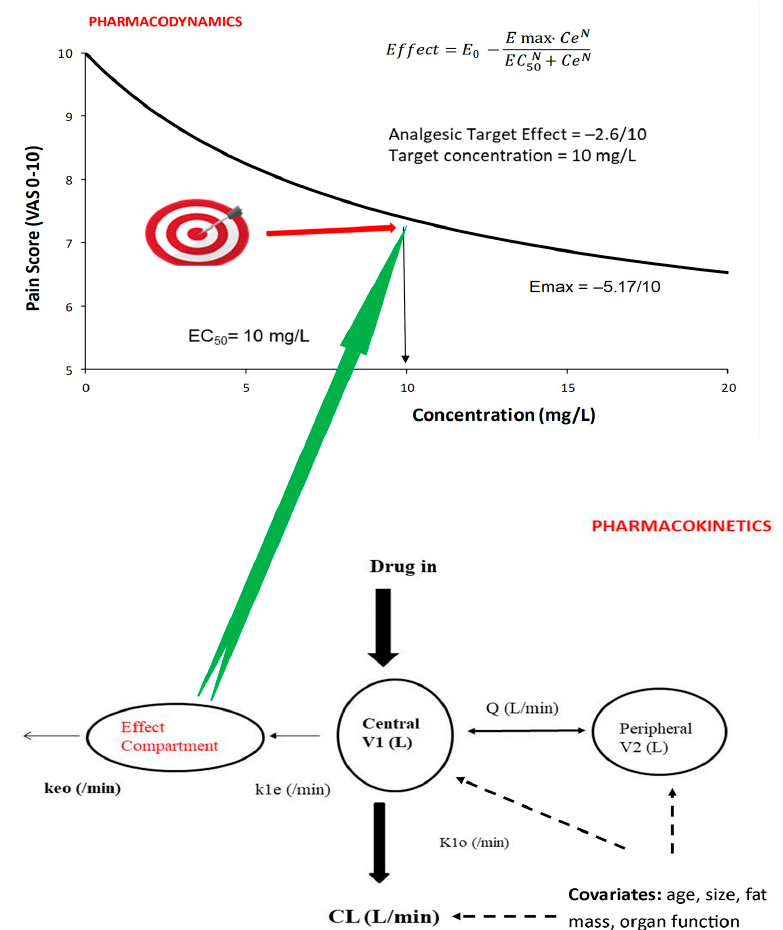
Figure 1. A diaphragmatic representation of the target concentration strategy. The upper panel shows the concentration–response for acetaminophen and analgesia. This response is described mathematically using the E MAX equation. The target effect of 2.6 pain unit reduction (VAS 0–10) is associated with a target concentration of 10 mg/L. A 2-compartment pharmacokinetic model (lower panel) is used to calculate a dose that achieves this target concentration in the effect compartment (Ce). Concentration in the central compartment (Cp) is linked to that in the effect compartment by a rate constant (k1e = keo at steady-state conditions). This equilibration rate constant (keo, determining rate from effect compartment to outside) is often expressed as the equilibration half-time (T 1/2